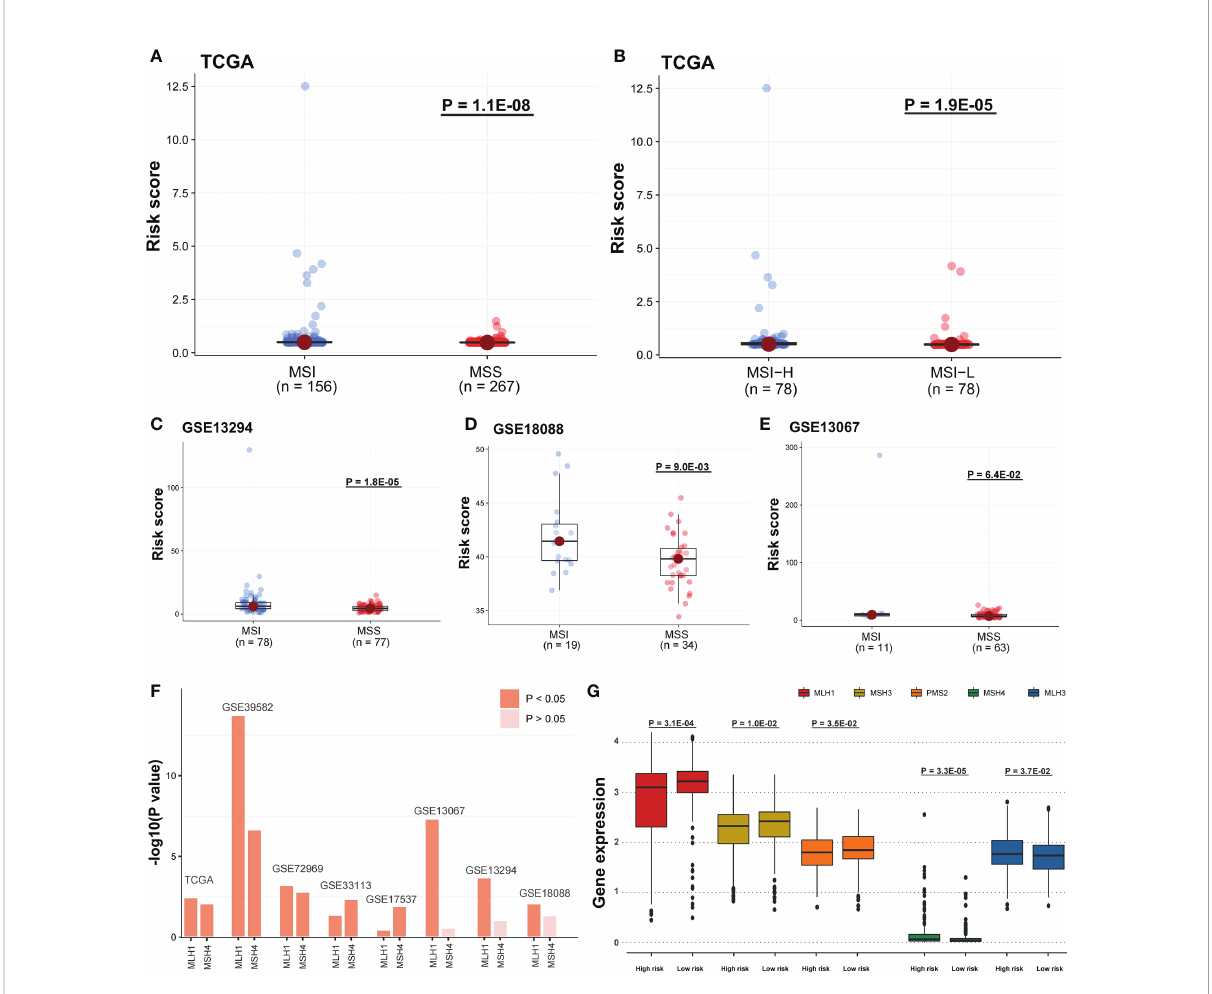
FIGURE 9 Risk scores were related to microsatellite stability status and the MMR gene expression. (A) A one-sided Wilcoxon rank-sum test was utilized for evaluating risk score differences in TCGA cohort between MSI and MSS groups and (B) MSI-H and MSI-L groups, and (C-E) in GSE13294, GSE18088, and GSE13067 cohorts between MSI and MSS groups. (F) Pearson correlation analysis was performed to evaluate the correlation between DNA mismatch repair (MMR) gene expression and risk score. The bars mean -log10 (P-value). (G) In TCGA cohort, the fi ve MMR gene expression differences among the two risk groups were evaluated by a one-sided Wilcoxon rank-sum test. Statistical signi fi cance is determined when P-value <